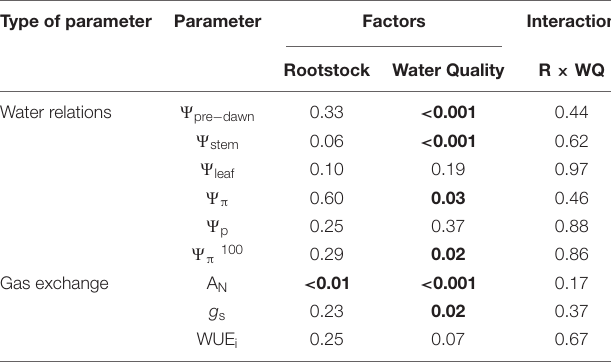
TABLE 1 | Significance of the factor effects in the two-way ANOVAs carried out for water relations and gas exchange parameters assessed in the Tempranillo cv. vines grafted onto M1, M4, and 1103-Paulsen